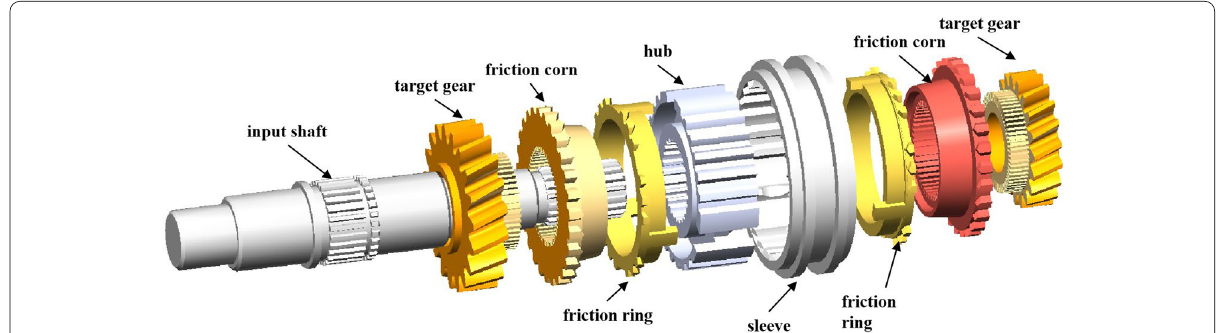
Figure 1 The structure and assembly relationship of ILRS